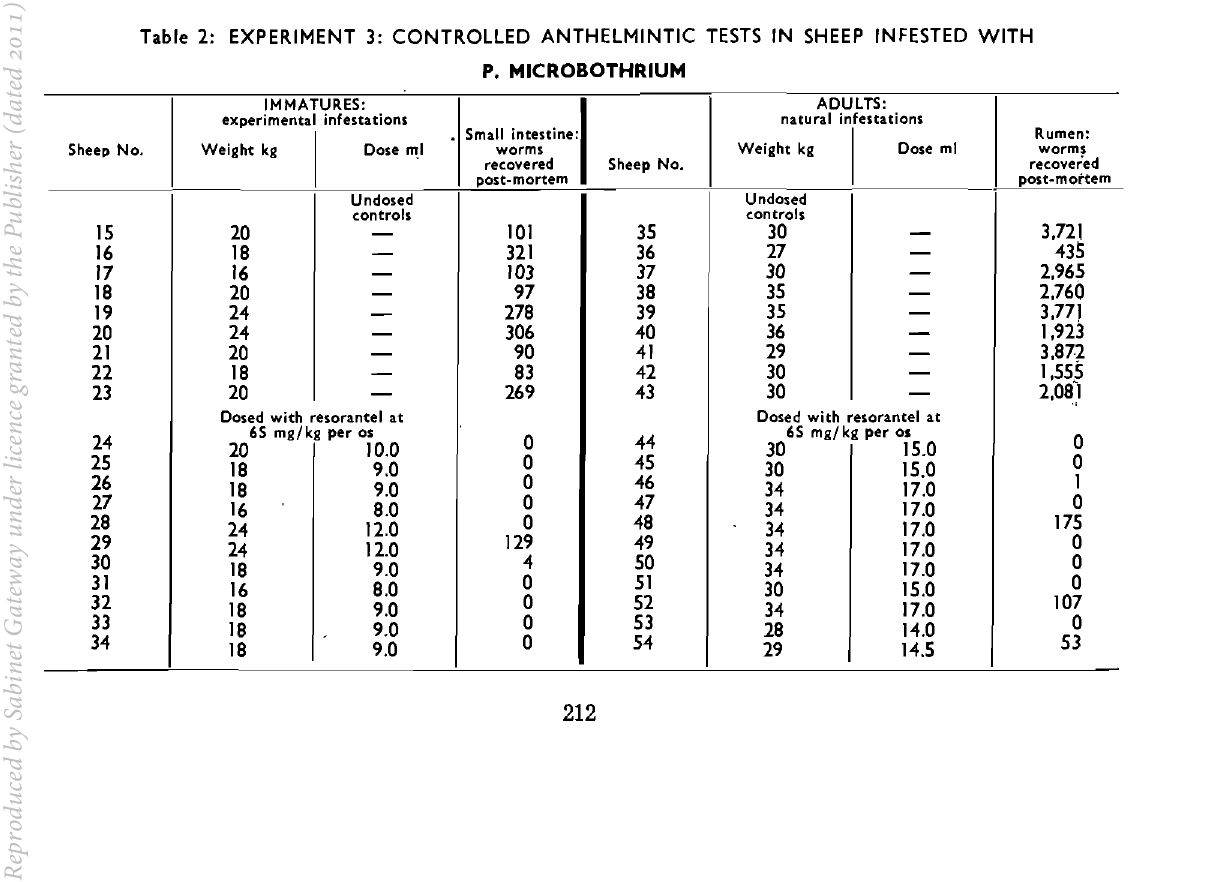
Table 2: EXPERIMENT 3: CONTROLLED ANTHELMINTIC TESTS IN SHEEP INFESTED WITH P.